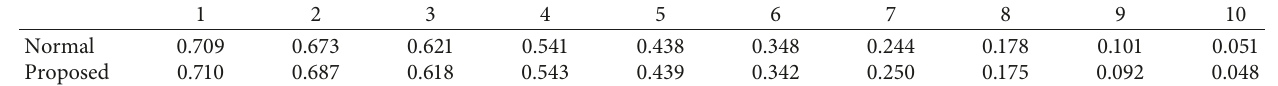
Table 2: Amplitudes of optimal results of the arrays with controlled